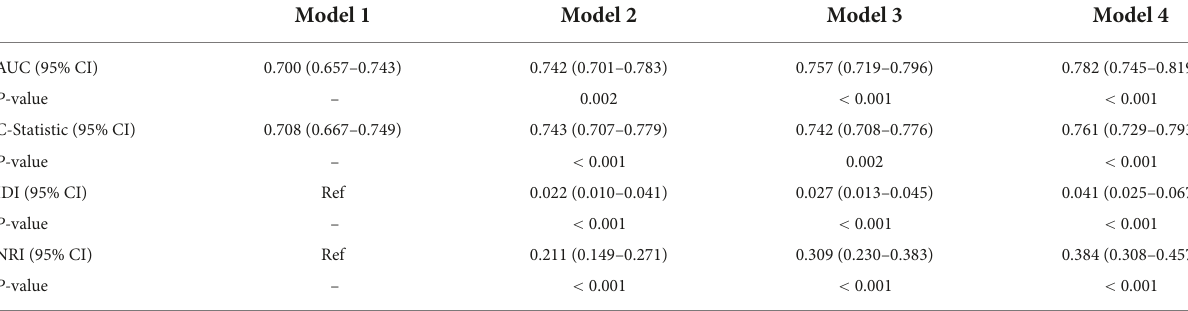
TABLE 3 Comparison of different risk prediction